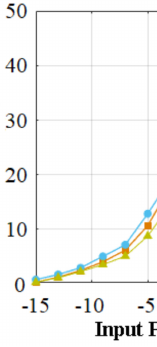
Figure 9. Measured PAE traces at different frequencies.